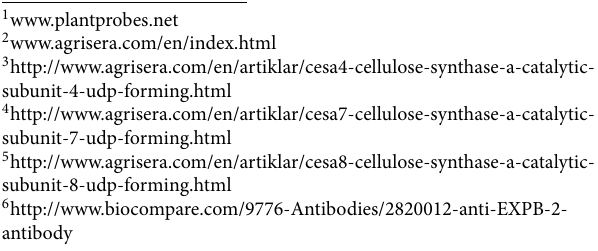
( Figure 1 ). Pedicels yellowed just before abscission. Immunodot assays and competitive inhibition ELISA performed by Willats et al. (1998) and Orfila and Knox (2000) indicated that the LM6 antibody is specific to (1 (cid:0)! 5)- a -L-linked arabinosyl residues with extended polymer, and reacts with rhamnogalacturonan (RG)-I but not RG-II. ELISA and glycan microarray performed by Marcus et al. (2008) indicated that LM15 binds specifically to xyloglucan, and competitive inhibition ELISAs determined that the structural feature for LM15 binding is the XXXG structural motif. Therefore, we used these probes to explore the occur- rence of specific cell wall polysaccharides and differences in their distribution during early fruit